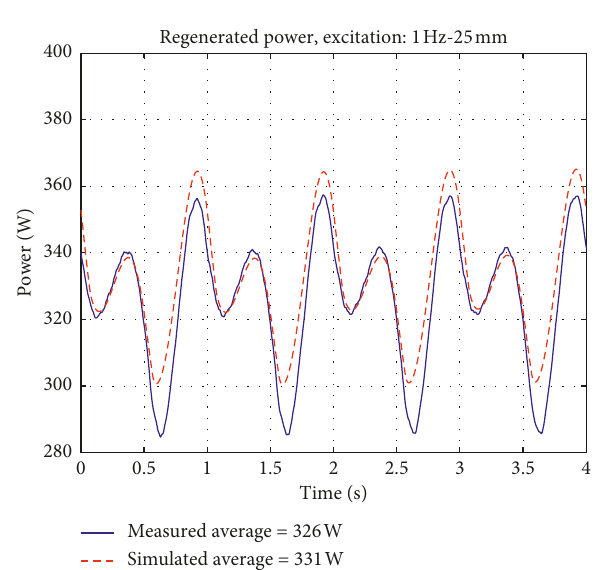
Figure 12: The validation of regenerated power